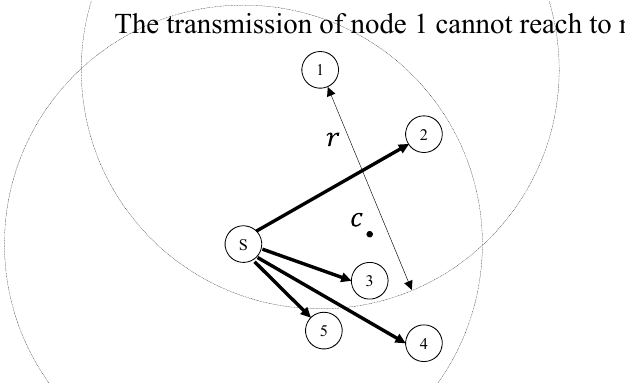
Figure 2. An example of the node selection